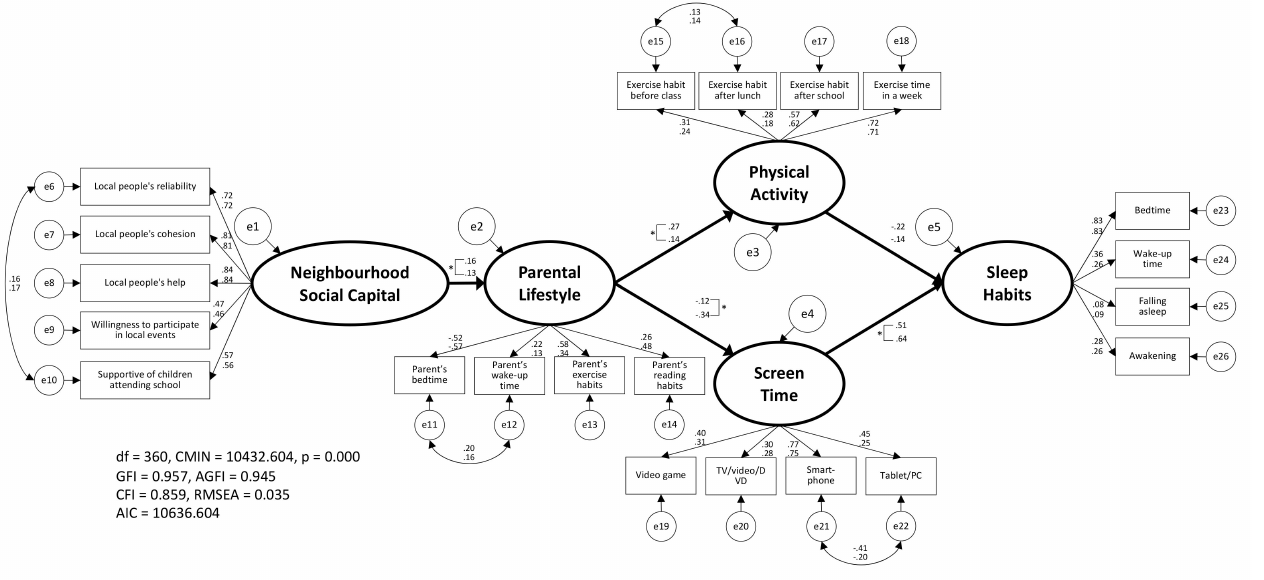
Figure 4. The pathways linking children’s sleep habits by sex. This model was verified by structural equation modeling using the bootstrap method. The numbers in Figure 4 pertain to upper: boys, and lower: girls, and all estimated values are significant. * The difference between boys and girls is significant at p <